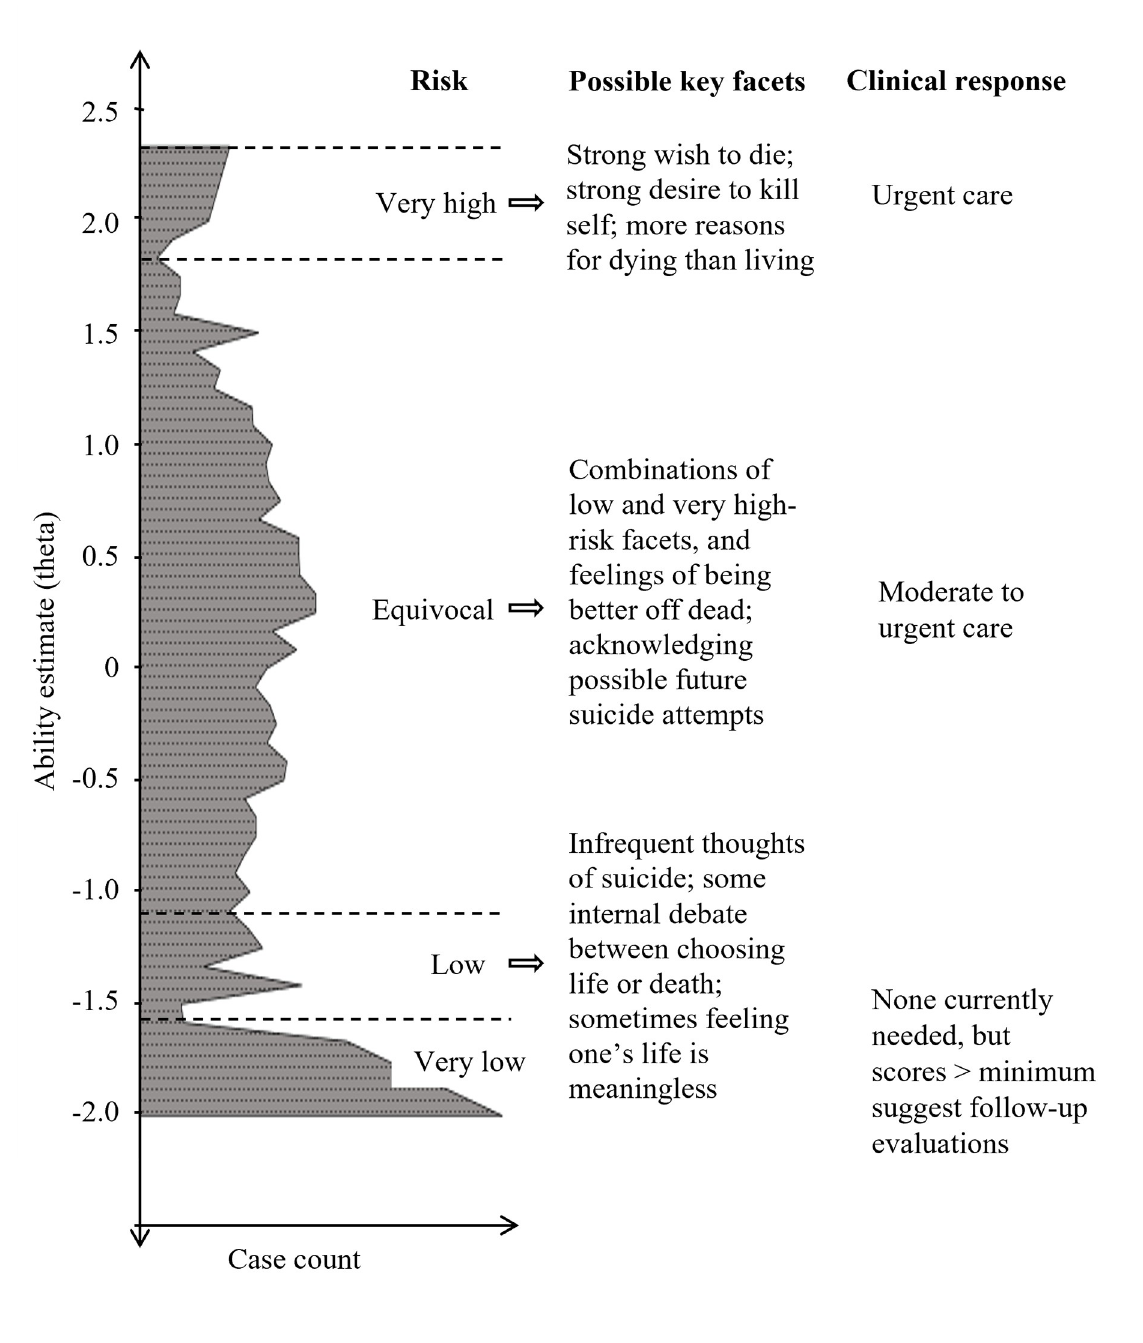
Fig 7. Suicidality Scale ability score frequencies, observed facets, and clinical directions. Study 1 data, N = 5,115. Key facets were observed across studies but require further validation. Risk levels are approximate and can change quickly. Clinical decisions require additional psychobiological